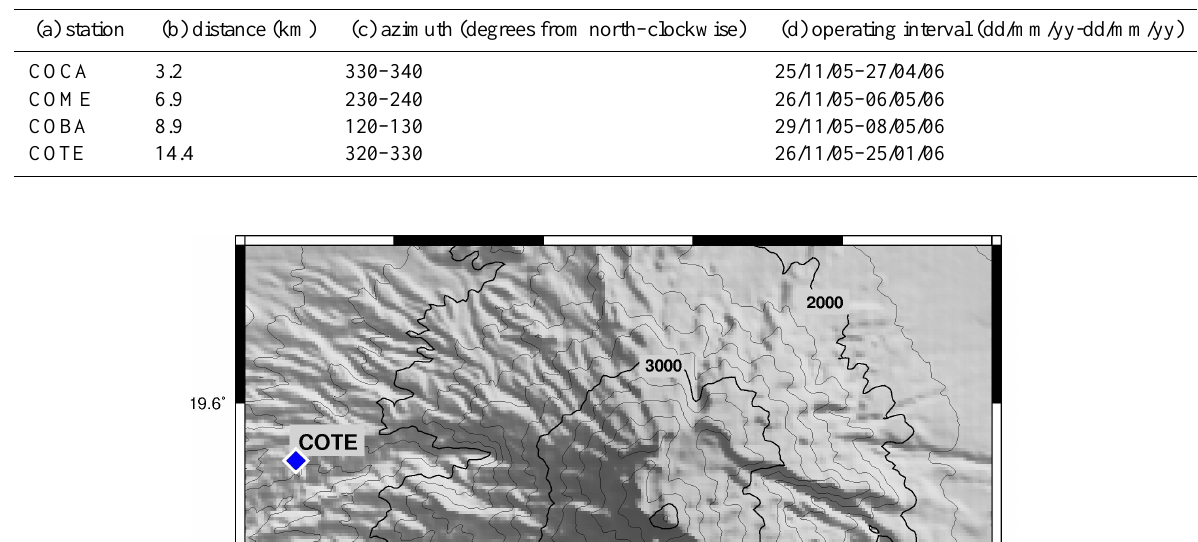
Table 1. (a–c) Position of the stations with respect to the crater in polar coordinates. The azimuth is measured from north direction clockwise. (d) Operating time-interval of each station.